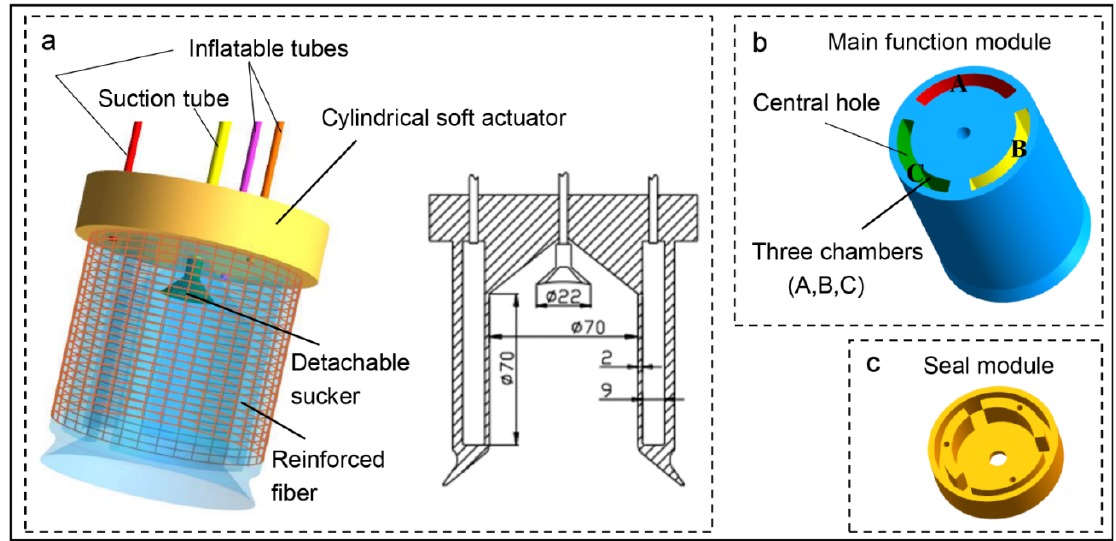
Figure 2. Structure of the novel combined soft gripper. ( a ) The novel combined soft gripper consists of a cylindrical soft actuator and a detachable sucker. ( b ) Structure of the main function module. ( c ) Structure of the seal module.